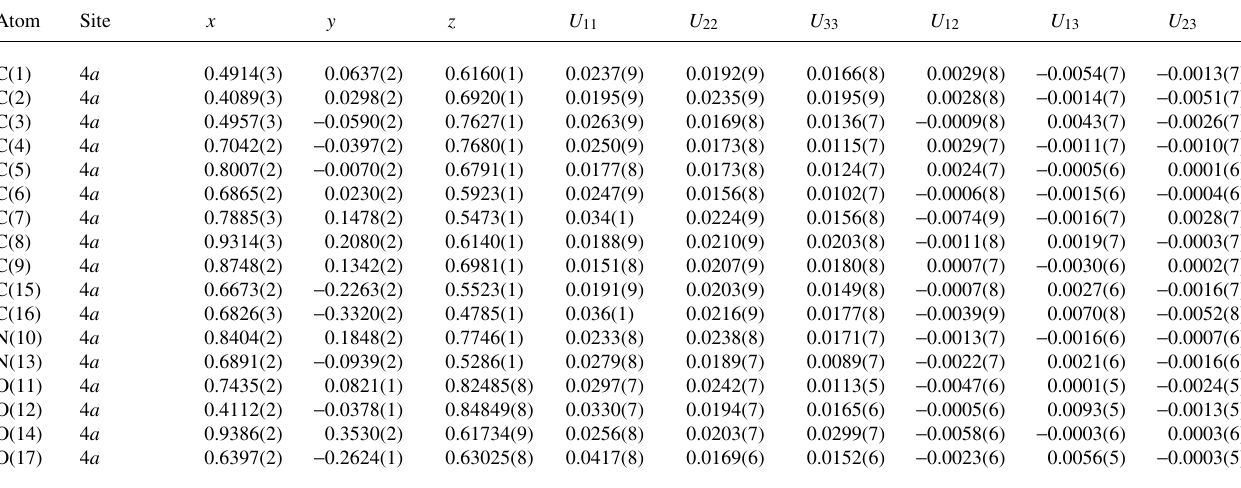
Table 3. Atomic coordinates and displacement parameters (in Å 2 ) .